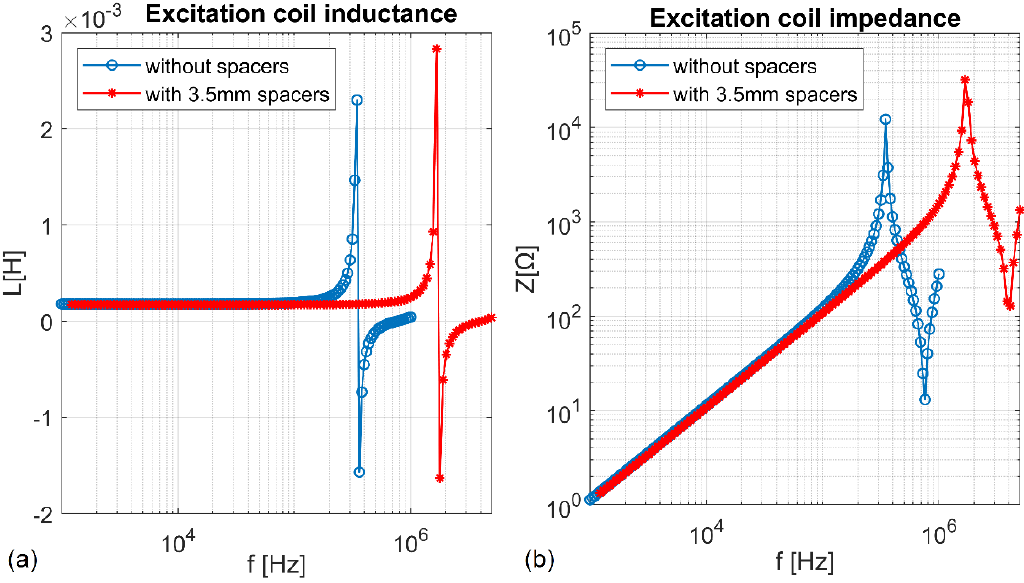
Figure 2. Inductance ( a ) and impedance ( b ) in a double − layer excitation coil with tightly adjacent layers (blue line) and with layers separated at a distance of 3.5 mm using wooden spacers (red line).